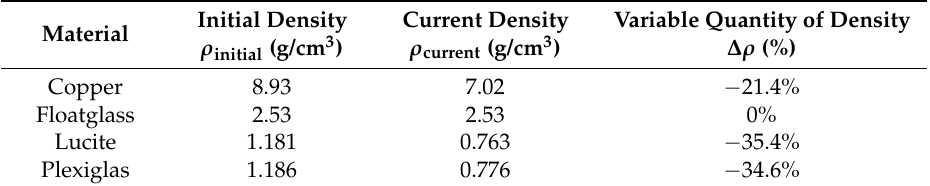
Table 7 . The density variation of four different shaped jet types.